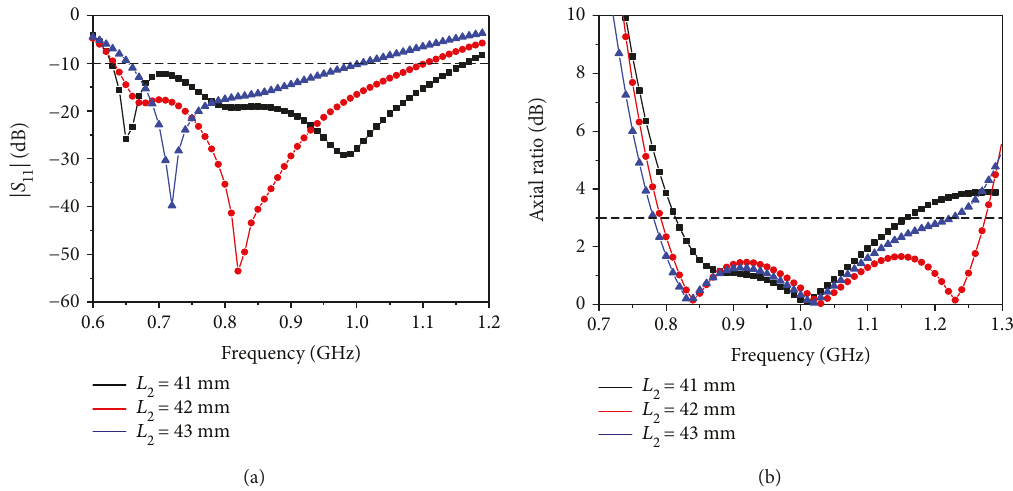
ff erent lengths of the L